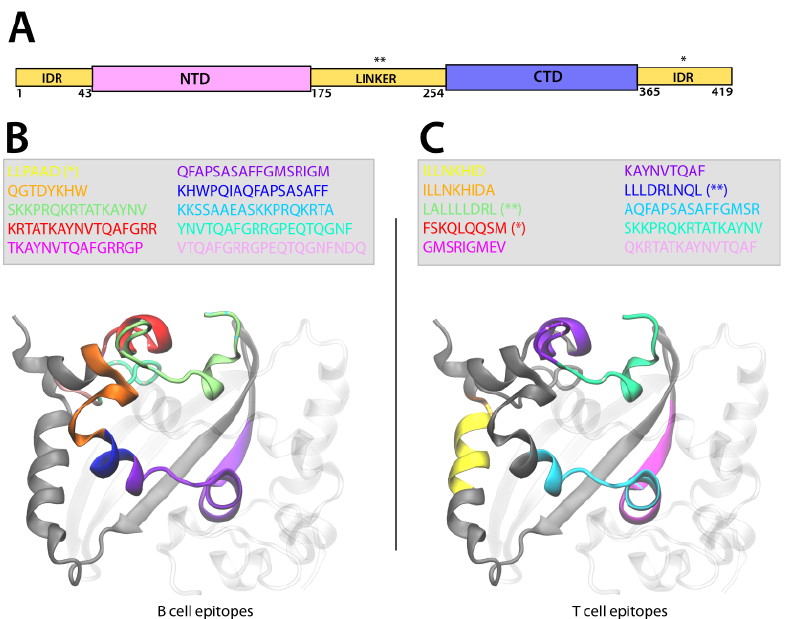
Figure 4. Representation of the localization of the B cell and T cell epitopes on the CTD domain of the Nucleoprotein. ( A ) Scheme of SARS-CoV-2 N domains illustrating the N-term intrinsically disorder region (IDR) followed by the N-terminal domain (NTD), the IDR linker, the C-terminal domain (CTD), and the C-term IDR. ( B , C ) The N CTD dimer is represented in New Cartoon format (one monomer is gray and the other is transparent), and the sequence of the B cell ( B ) and T cell ( C ) epitopes is colored according to the legend represented in the figure. The epitope sequence is represented in the legend. The epitopes located in the linker domain are indicated by (**) and those in the C-term IDR by (*). For great clarity, we represented the epitopes in only one monomer.